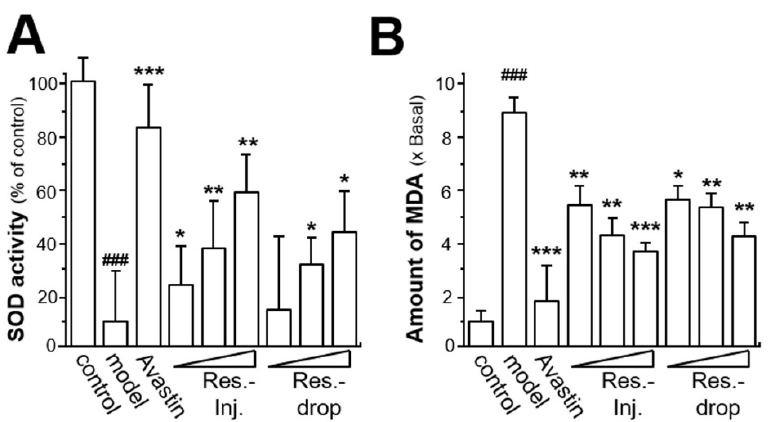
Figure 5. Resveratrol releases oxidative stress by enhancing SOD activity and decreasing MDA activity. ( A ) The quantification of SOD activity and ( B ) the quantification of MDA activity in the collected blood. The data are expressed as the percentage of control or the fold of change of control (x basal), in mean ± SEM, where n = 6; ### p < 0.001 vs. the control group; * p < 0.05; ** p < 0.01; *** p < 0.001 vs. the model group.